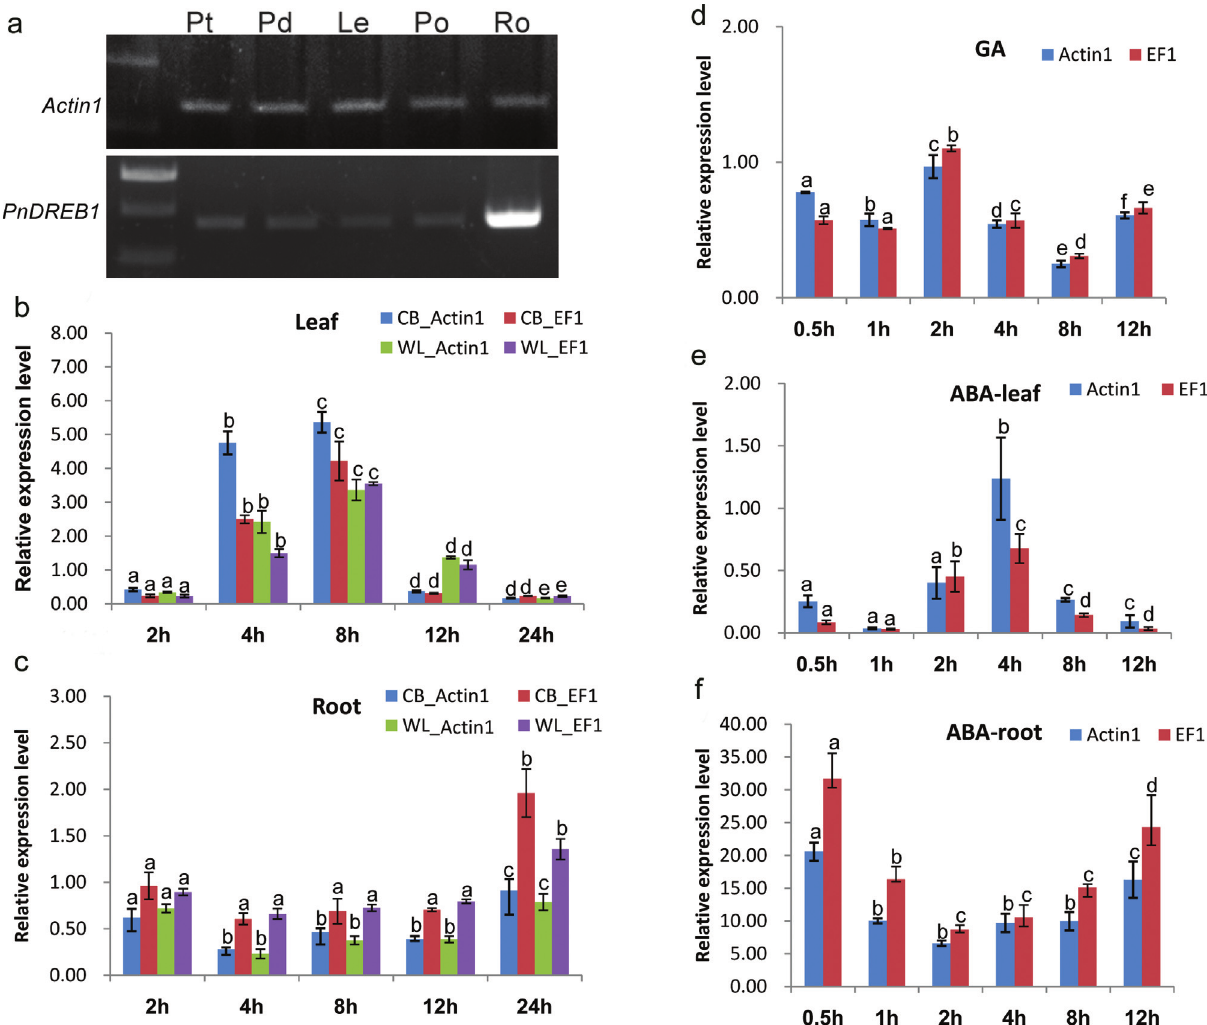
Figure 5 - Expression profiles of PnDREB1 . (a), Semi quantitative RT-PCR analysis of spatial expression patterns in petal (Pt), pedicel (Pd), leaf (Le), petiole (Po), and root (Ro); b and c) show qPCR analysis results; relative expression levels of PnDREB1 at different time points (x-axis) of freezing treat- ment in leaf and root, respectively, in fold-change (y-axis); d) qPCR analysis results showing changes of relative expression levels of gibberellins acid- (GA 3 , 80 (cid:2) M) treated plants under same treatment as those of b); e and f) fold changes of relative expression levels under treatment of 100 (cid:2) M abscisic acid(ABA).CB,ChampagneBubbles;WL,Wonderland.Dataareshownasmeans (cid:6) SD(n=3). Actin1 and EF1 wereusedasinternalcontrols.Different lowercase letters on rectangular columns indicate significant differences to that of previous time point (P <